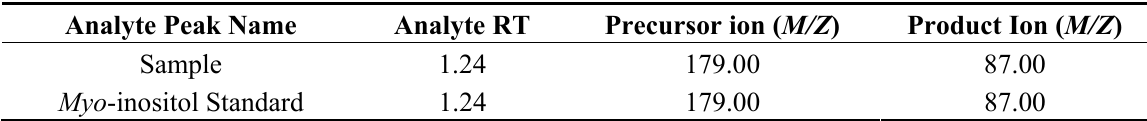
Table 1. Summary of the LC-MS/MS analysis on the crystals from red dragon fruit and myo -inostiol standard.